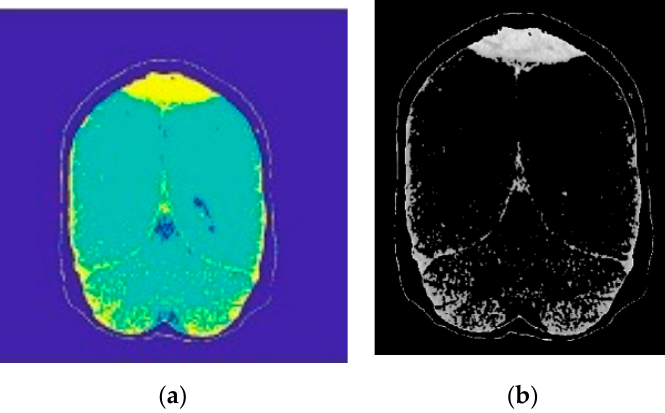
Figure 3. Illustration of images obtained ( a ) before and ( b ) after applying Otsu’s segmentation method.